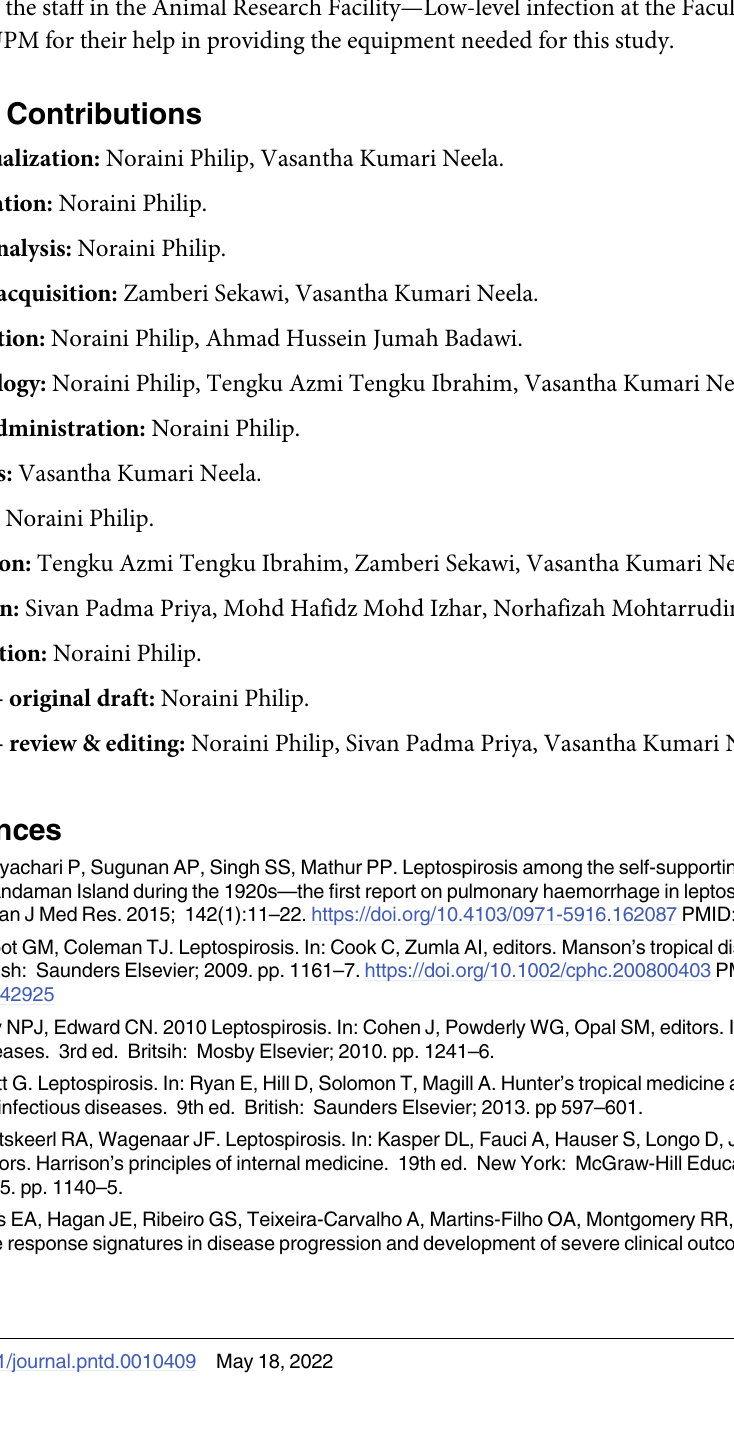
S2 Table. Fold gene expression value of pro-inflammatory cytokines. S3 Table. Fold gene expression value of pro-inflammatory chemokines. S4 Table. Fold gene expression value of anti-inflammatory